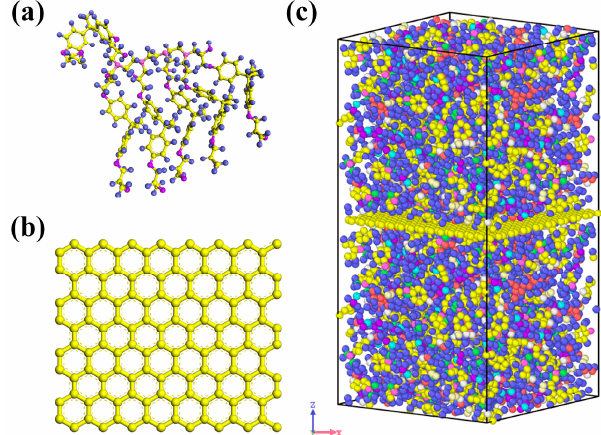
Figure 1. The molecular model of ( a ) representative molecular, ( b ) pristine Gr and ( c ) Gr/epoxy nanocomposite. (blue balls are hydrogen atoms, purple balls are oxygen atoms, lilac balls are nitrogen atoms, yellow balls are carbon atoms in epoxy, respectively).